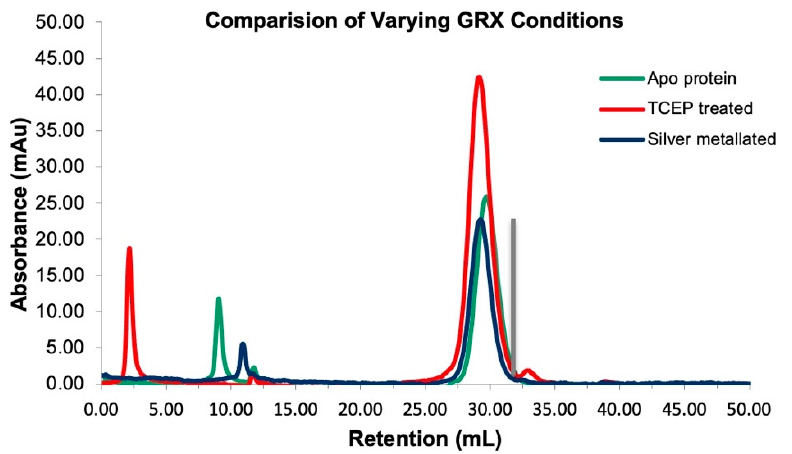
Figure 4. Size exclusion chromatography shows that the reduced apo protein (green), excess TCEP treated (red) and silver metalated protein (blue) elute at nearly identical retention volumes compatible with dimer formation.